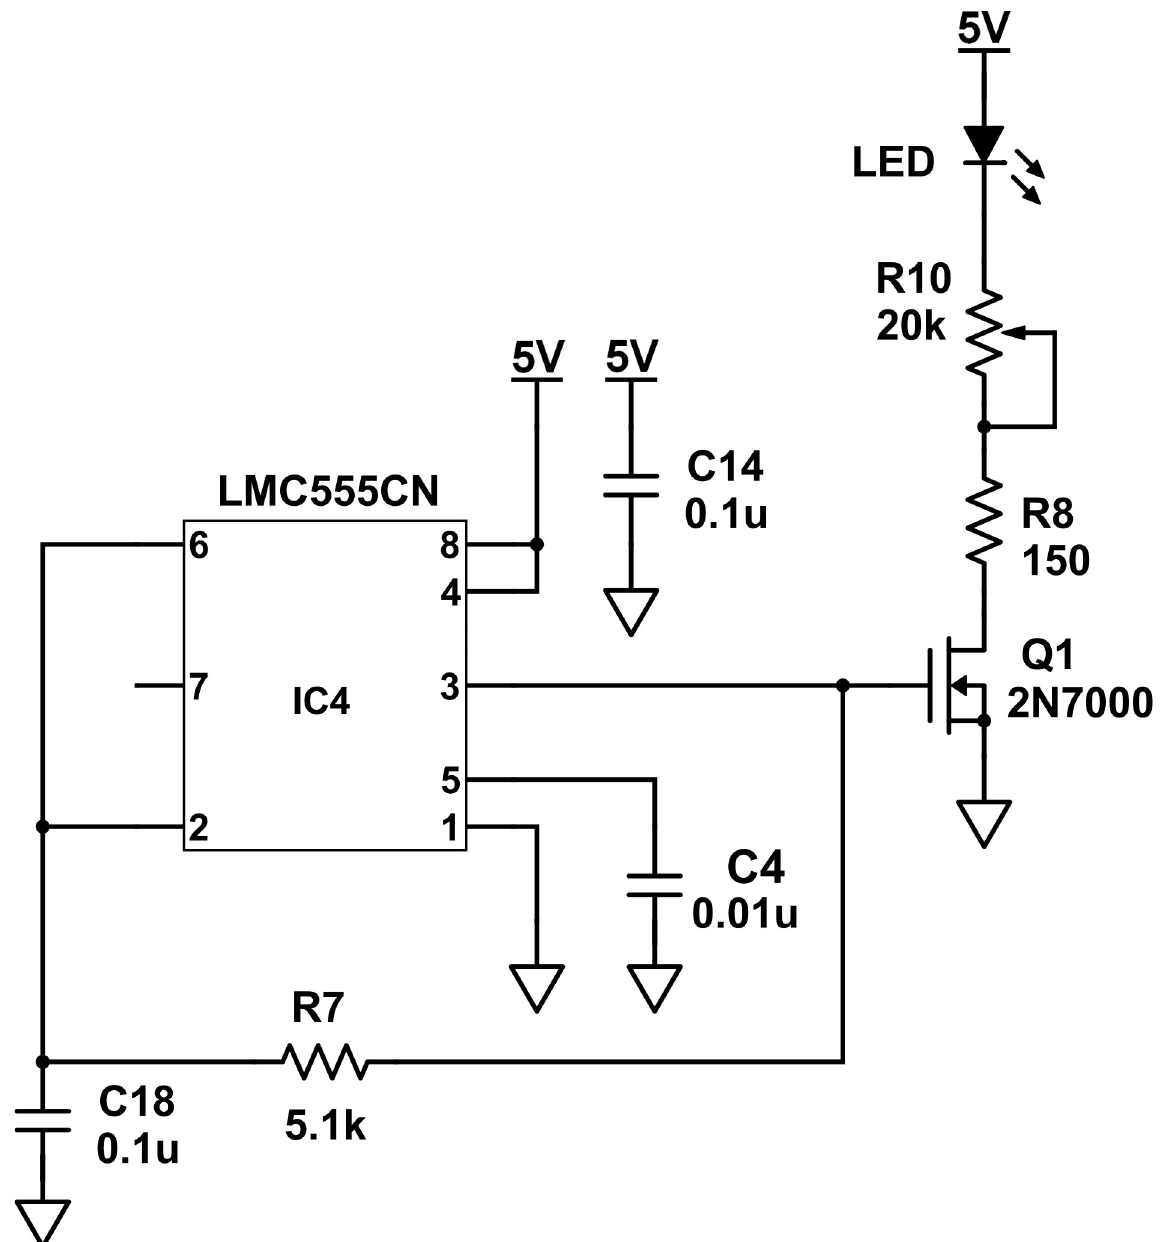
Fig 5. A schematic diagram of the light emitting diode (LED) source